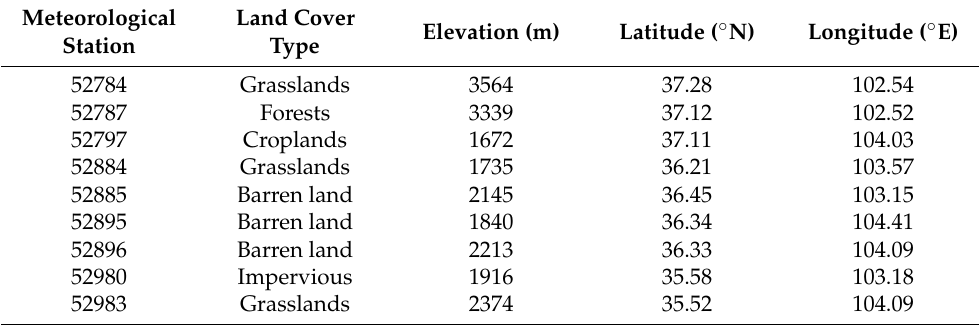
Table 1. Land cover types, elevations, and geographic coordinates of the nine meteorological stations in our study area. The locations of the nine stations are shown in Figure